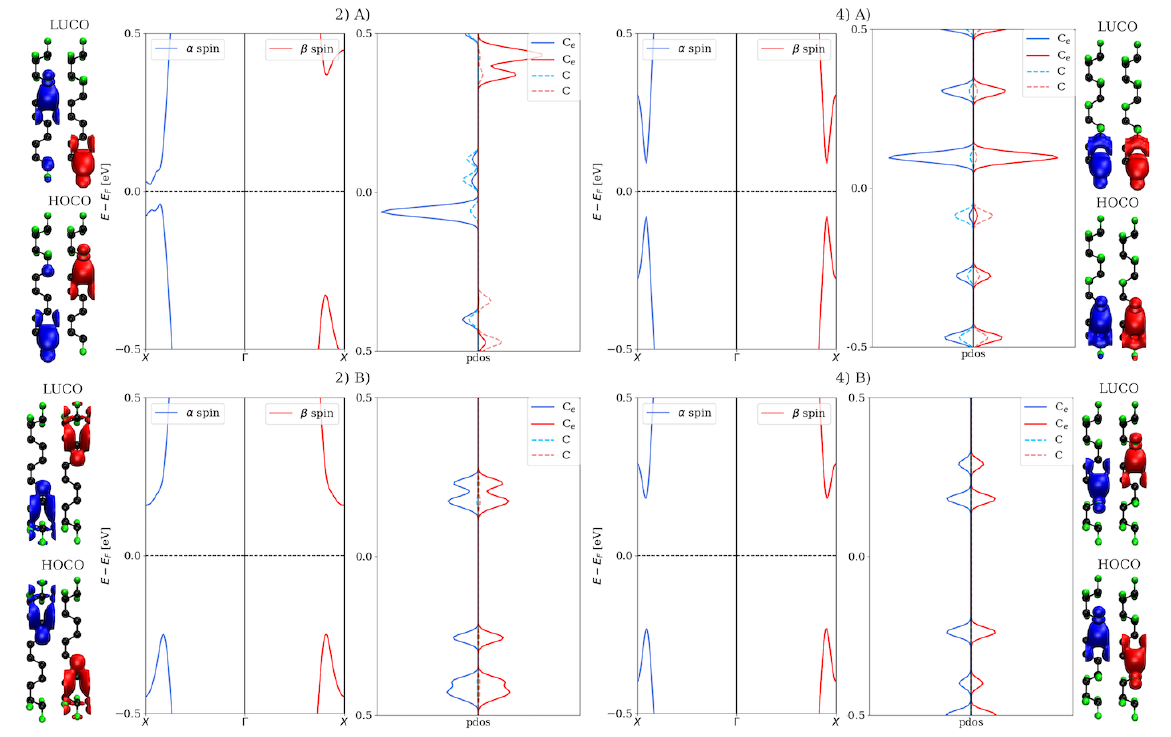
Figure 5. Bandstructures and projected densities of states (PDOS) on two configurations of the 33.33% and 66.67% fluorinated F-6ZGNRs are shown. The lowest unoccupied crystal orbitals (LUCO) and highest occupied crystal orbitals (HOCO) for each structures are illustrated.The α and β spin channels are presented in red and in blue,